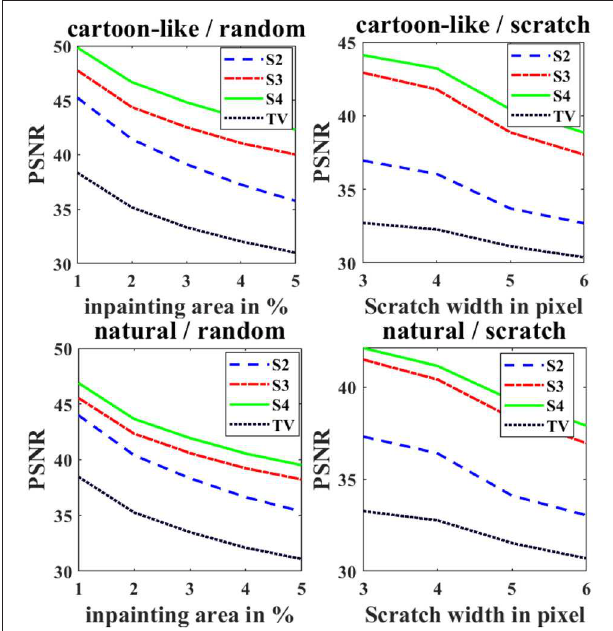
FIGURE 7 | Inpainting scratches: damaged image (top, left), reconstruction using standard TV inpainting (top, right), and reconstruction using spline inpainting of order 2 and 3 (bottom).